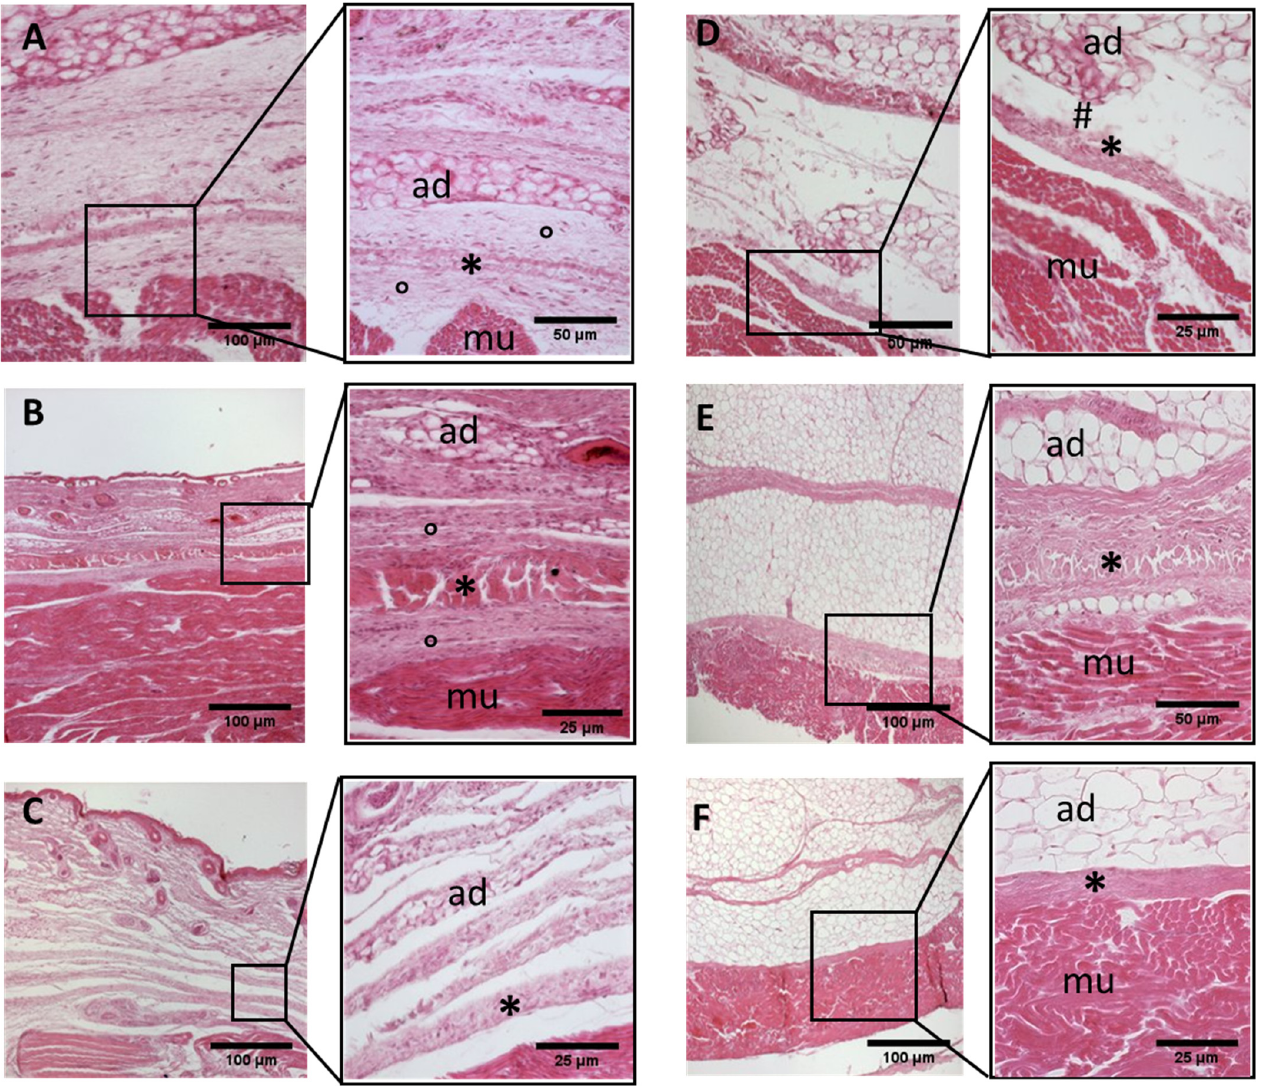
Figure 2. Histological images (hematoxilyn-eosin) of lower limb, thigh: anterior fascia develop- ment. ( A ): 24 weeks; ( B ): 27 weeks; ( C ): 29 weeks; ( D ): 36 weeks; ( E ): 38 weeks; ( F ): 40 weeks. (*): deep fascia; (°): mesenchymal cells; (#): areolar tissue; (mu): muscle; (ad): adipose tissue. The first